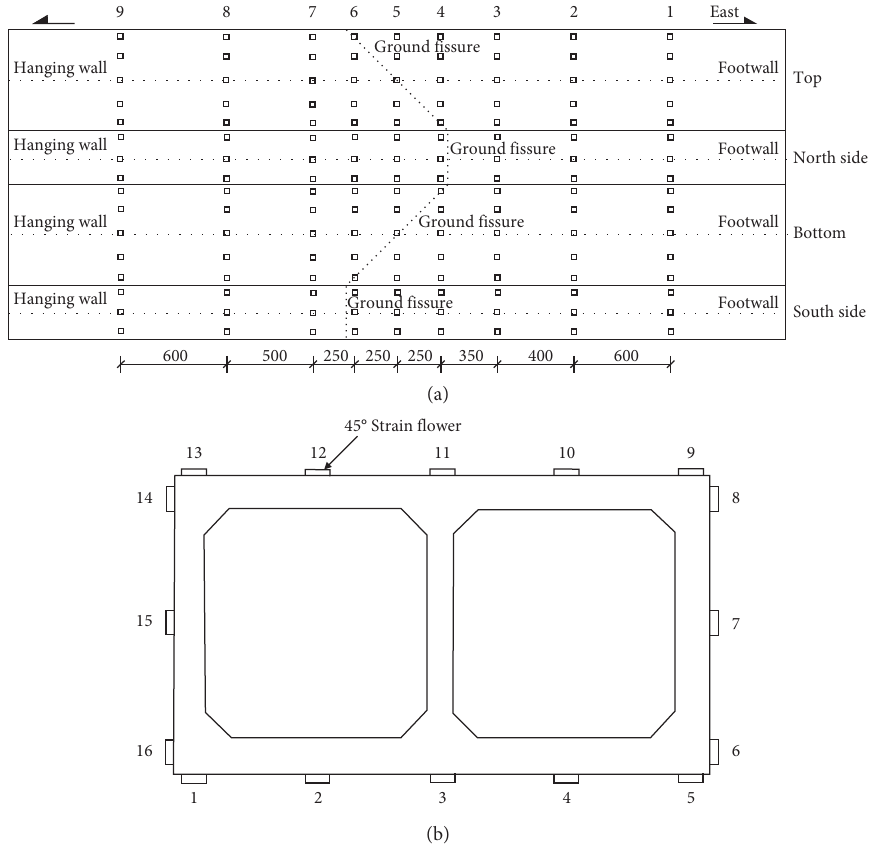
Figure 5: Structural strain flower arrangement (cm). (a) Position of structural strain flowers (cm). (b) Cross-sectional strain flowers layout